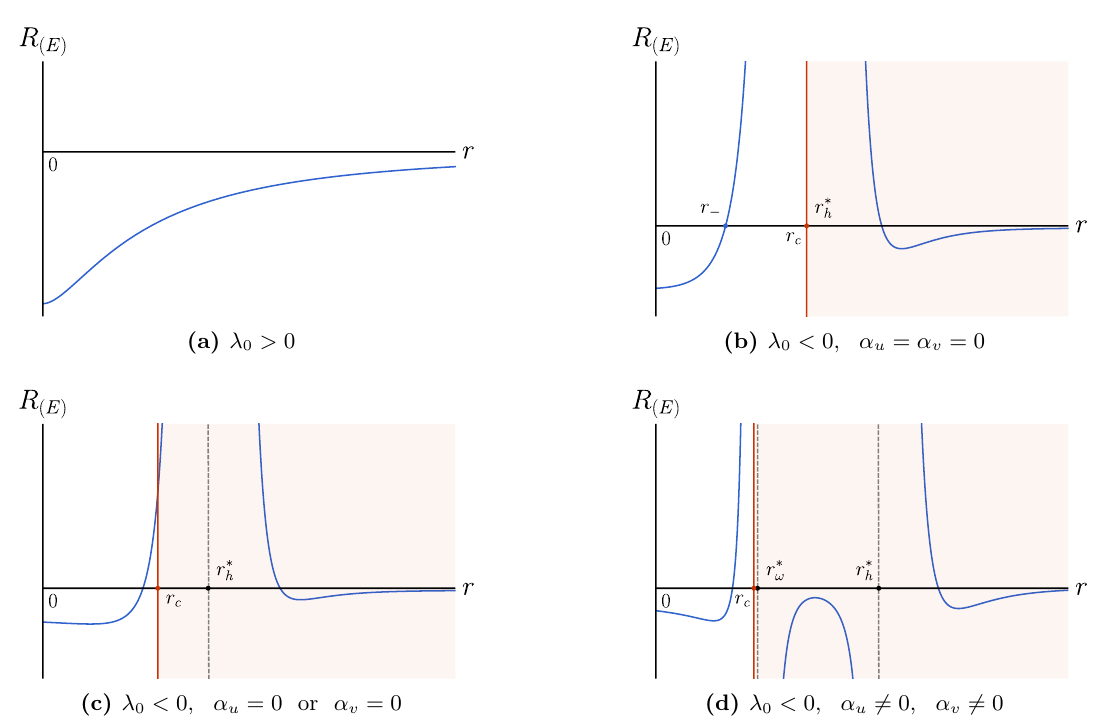
¯ Figure 2. The Ricci scalar for T T backgrounds with generic values of the T u and T v parameters and different choices of α and α (not drawn to scale). When 0 < λ u v everywhere and the spacetime is smooth and free of CTCs. When λ a region of positive curvature that is found before any CTCs (the shaded region) or curvature singularities (dashed lines) are